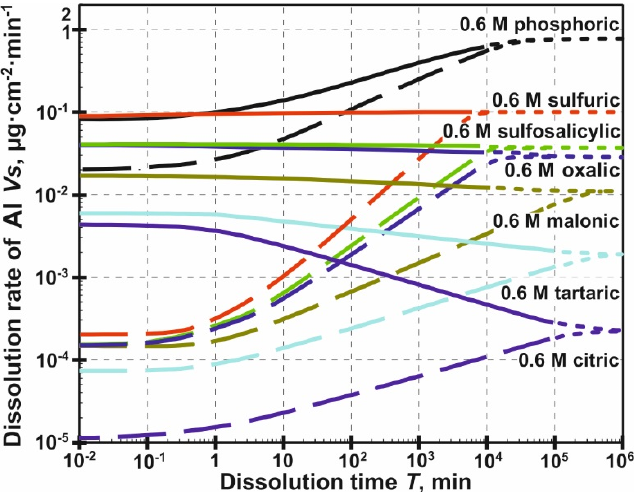
Figure 3. Dependence of the dissolution rate V s , µ g · cm − 2 · min − 1 for the unprotected Al (solid line) and its barrier anodic oxide layer (dashed line) on the exposure time ( T , min) of the samples in acid solutions; short dashed